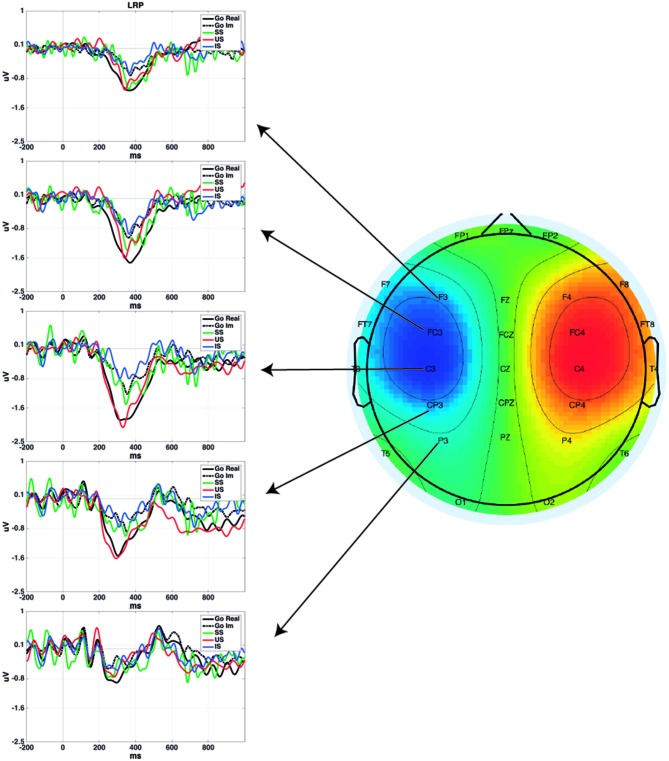
Lateralized Readiness Potential (LRP) time-locked to the go signal for each condition in different scalp locations. Plotted grand averages of Successful Stop (SS) and Unsuccessful Stop (US) were computed using 12 participants, while Go Real, Go Im and Imagined Stop (IS) were computed using 18 participants. Topography represents the mean LRP amplitude of all conditions from 200 to 400 ms.